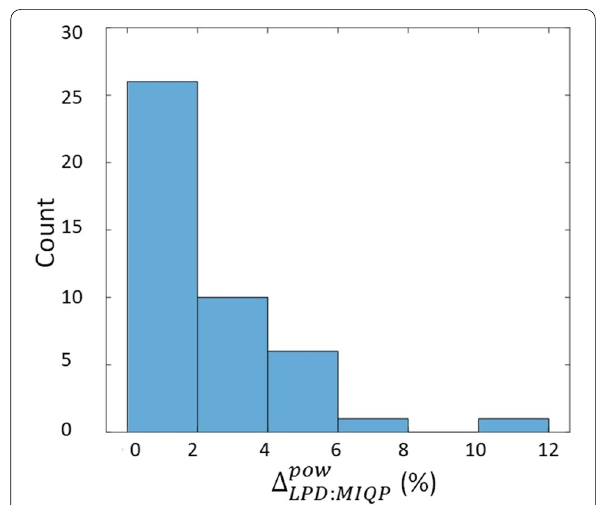
Fig. 5 Power by LPD vs MIQP (44 models solved by